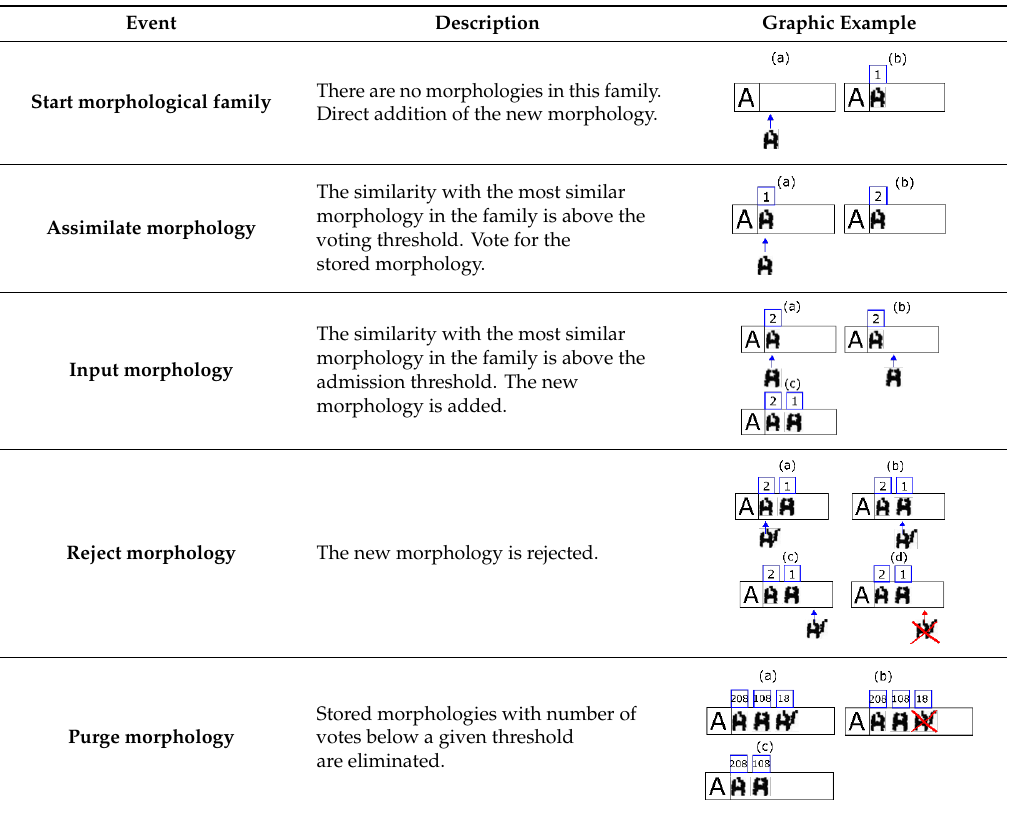
Table 2. Relationship of events with their meaning for learning during automatic learning time.